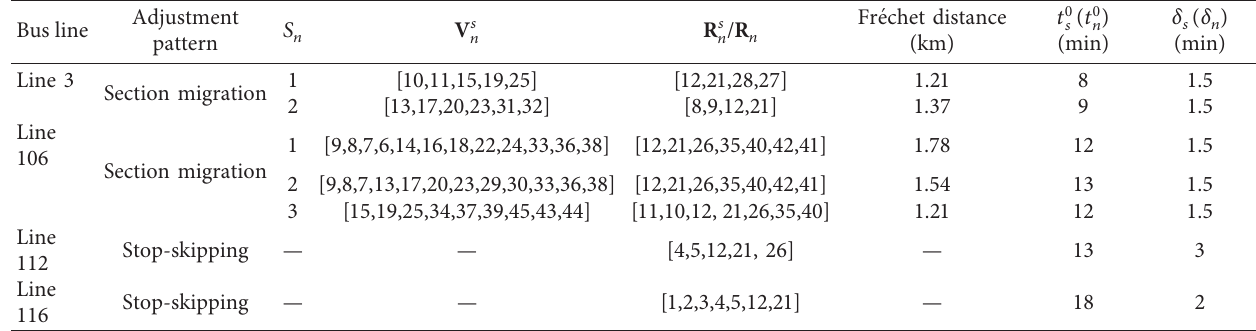
Table 4: Information of the rerouting